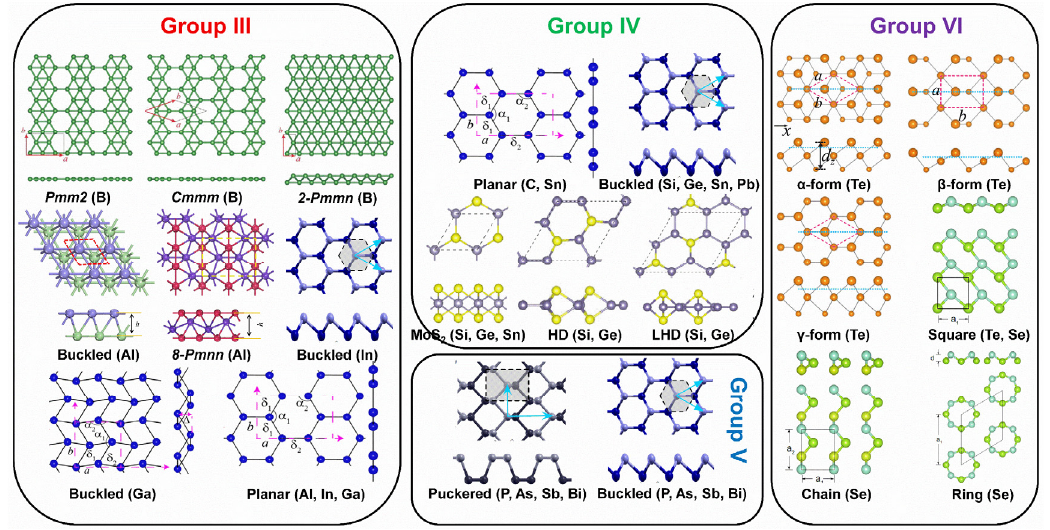
Figure 2. Allotropes of various 2D Xenes in main groups predicted theoretically or created experi- mentally. The dotted boxes represent the unit cells. Allotropes of borophene: Reprinted with per- mission from Ref. [54]. Copyright 2017, Informa UK Limited, trading as Taylor & Francis Group. Allotropes of aluminene: Reprinted with permission from Ref. [55]. Copyright 2017, Elsevier Ltd. Allotropes of gallenene: Reprinted with permission from Ref. [29]. Copyright 2018, American Asso- ciation for the Advancement of Science. Buckled and puckered structures: Reprinted with permis- sion from Ref. [56]. Copyright 2016, American Physical Society. MoS 2 -like, HD, and LHD structures: Reprinted with permission from Ref. [57]. Copyright 2015, American Physical Society. α -form, β - form, and γ -form of tellurene: Reprinted with permission from Ref. [27]. Copyright 2017, American Physical Society. Square-, chain-, and ring-Se: Reprinted with permission from Ref. [58]. Copyright 2017, IOP Publishing.